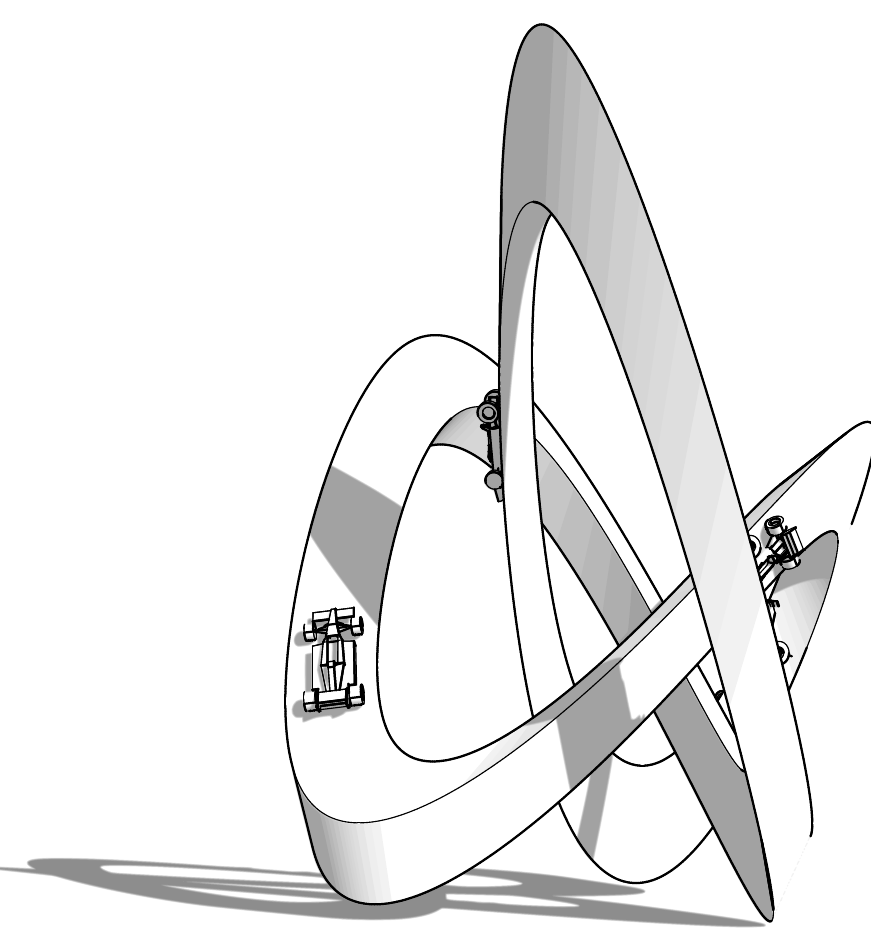
Figure 25. Sculpture in the form of a trefoil knot, 3D